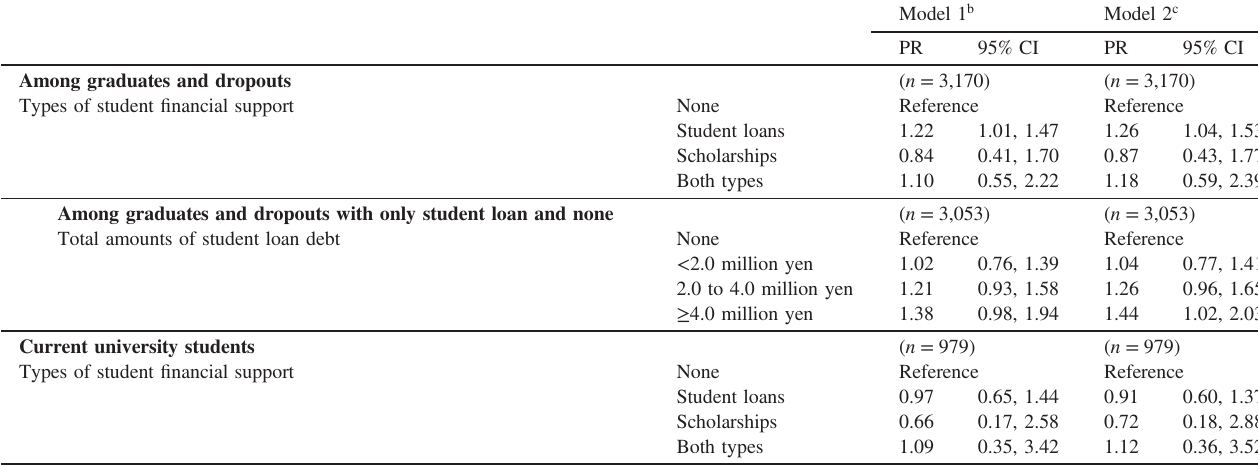
Table 3. Associations of the types of student fi nancial support and the total amount of student loan debt with severe psychological distress a from Poisson regression models with a robust error variance strati fi ed by current student status after